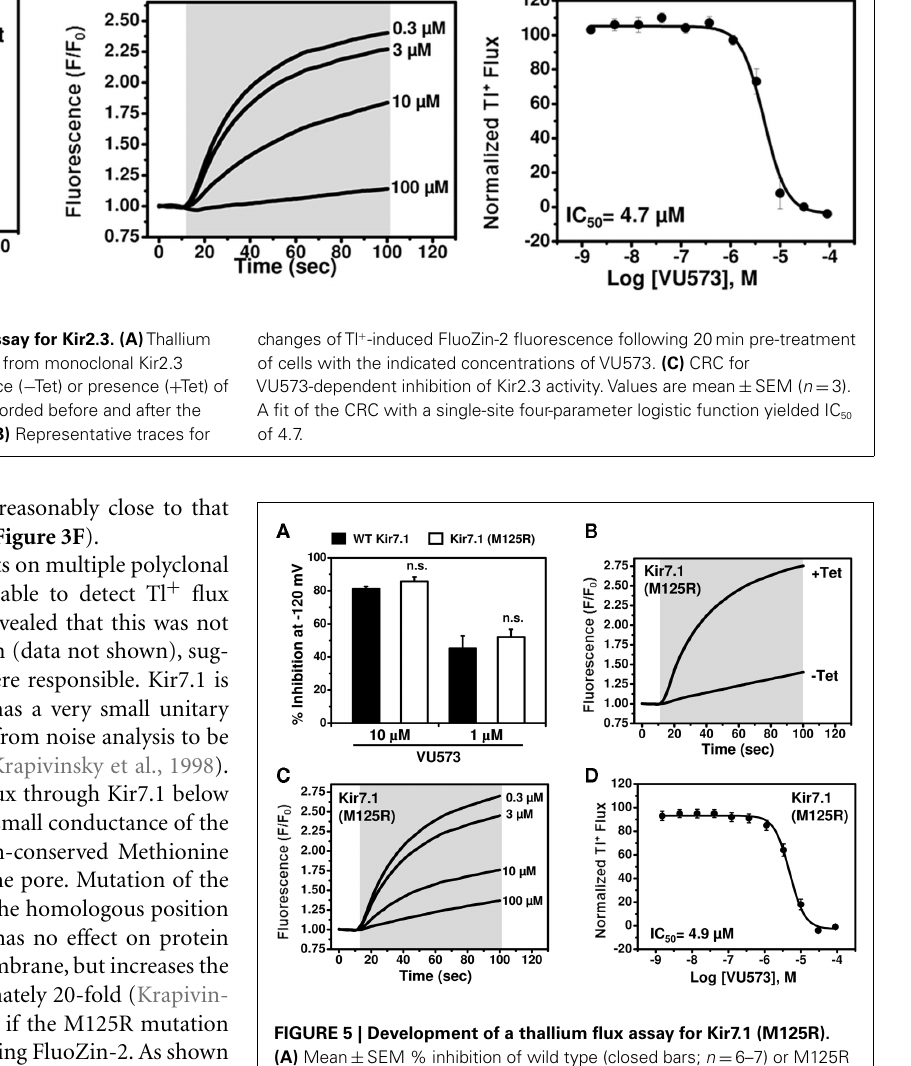
FIGURE 5 | Development of a thallium flux assay for Kir7.1 (M125R). (A) Mean ± SEM % inhibition of wild type (closed bars; n = 6–7) or M125R mutant (open bars; n = 4–6) Kir7.1 by the indicated concentration of VU573.Note that the wild type data are reproduced from Figure 3 . (B) Thallium flux-dependent FluoZin-2 fluorescence recorded from polyclonalKir7.1 (M125R)T-REx-HEK-293 cells cultured overnight in absence ( − Tet) or presence ( + Tet) ofTetracycline.The fluorescence emission was recorded before and after the addition of extracellular thallium (shaded box). (C) Representative traces for changes ofTl + -induced FluoZin-2 fluorescence following 20min pre-treatment of cells with the indicated concentrations of VU573. (D) CRC forVU573-dependent inhibition of Kir2.3 activity.Values are mean ± SEM ( n = 3). A fit of the CRC with a single-site four-parameter logistic function yielded IC 50 of 4.9 μ